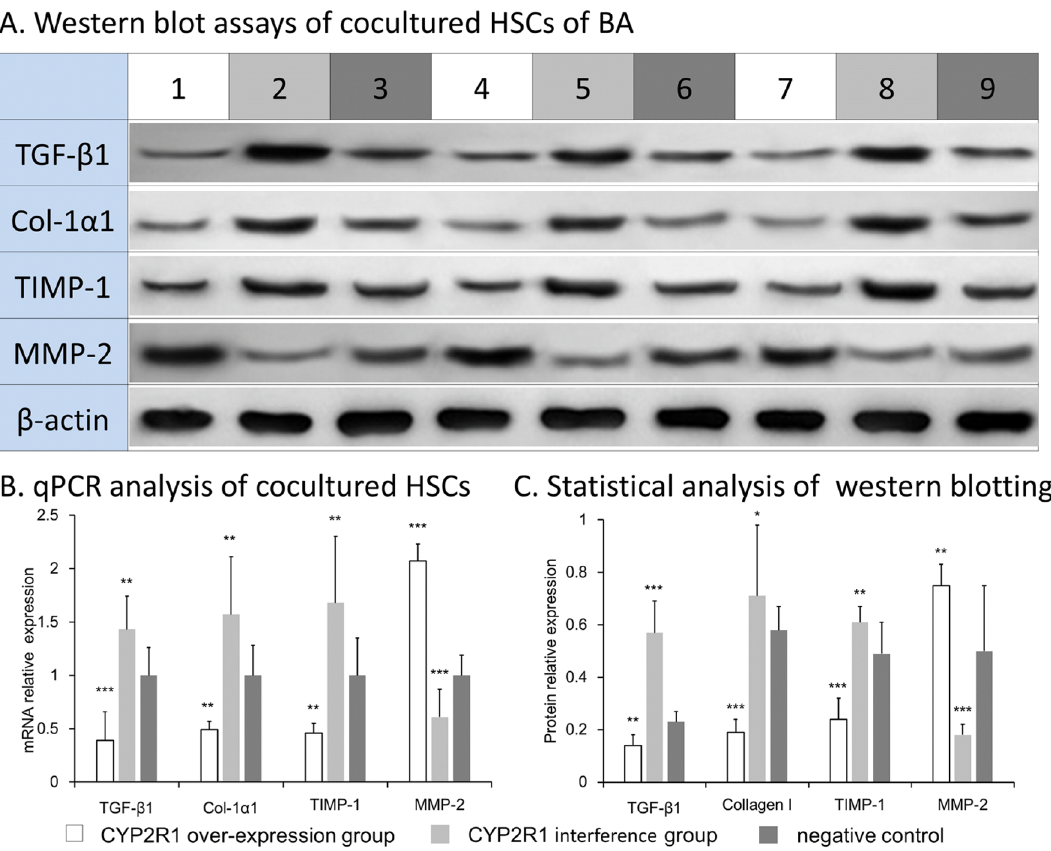
Figure 5. Regulation of expression of CYP2R1 in hepatocytes can change mRNA and protein expression of fibrosis-related factors in cocultured primary HSCs of BA. ( A ) protein expression of fibrosis-related factors in CYP2R1-overexpression group (columns 1, 4 and 7), CYP2R1-interference group (columns 2, 5 and 8) and negative control group (columns 3, 6 and 9). ( B,C ) statistical results of qPCR and western blotting detection of fibrosis-related factors in each intervention